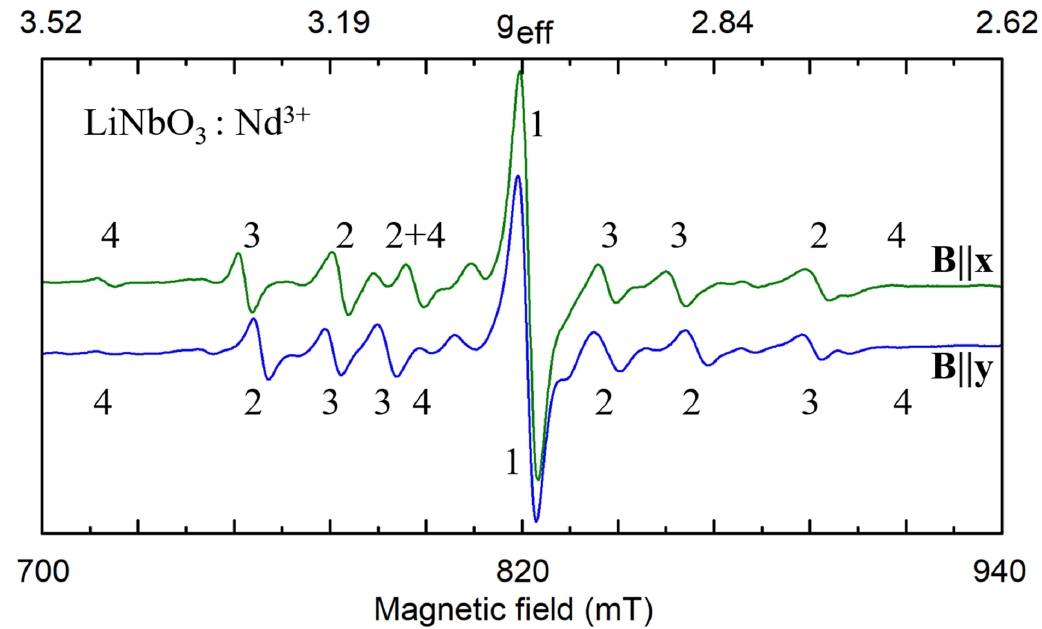
Figure 2. Fragments of electron paramagnetic resonance (EPR) spectra of Nd 3+ impurity ions in nearly stoichiometric lithium niobate (LN) for microwave frequency ν = 34.445 GHz, T = 19 K. The numbers 1–4 correspond to four different electrically non-equivalent defects. Lines of magnetically nonequivalent partners have the same number.